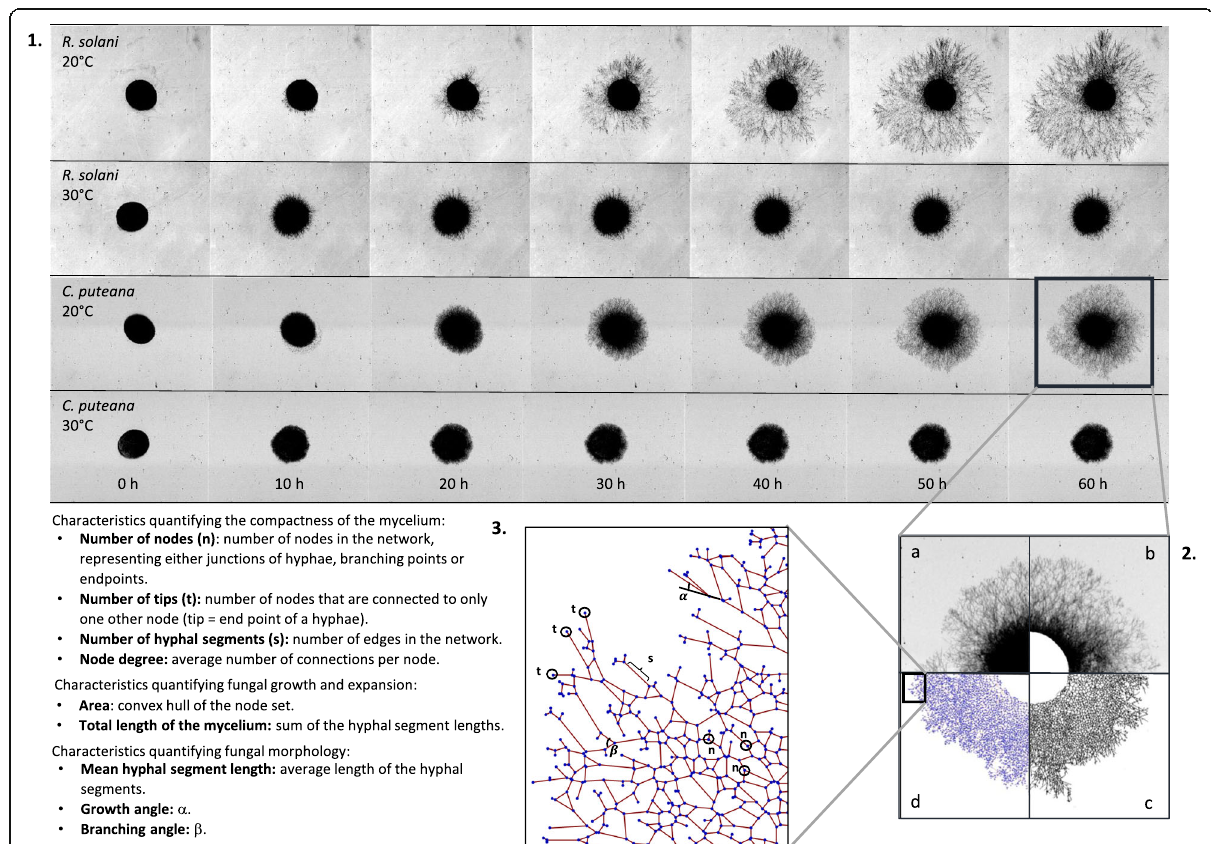
Fig. 2 1. Images of C. puteana and R. solani in function of time at 75% RH in combination with 20 °C and 30 °C. 2. Summary of the entire process of characteristic extraction. a) Initial image; b) Pre-processed image; c) Binary ridge map; d) Graph. 3. Representation of characteristics quantifying fungal